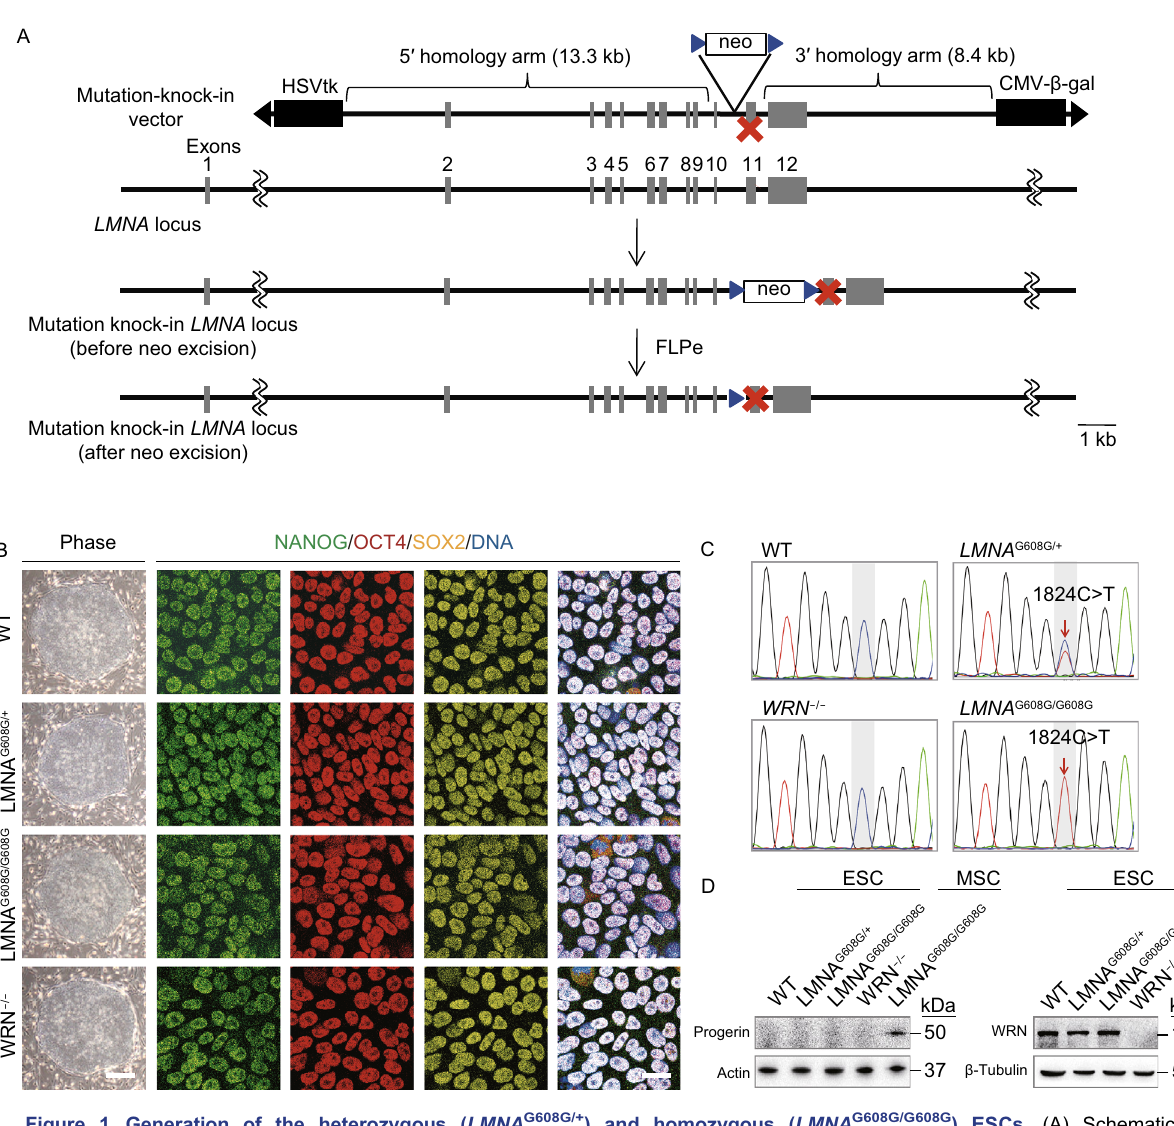
Figure 1. Generation of the heterozygous ( LMNA G608G/+ ) and homozygous ( LMNA G608G/G608G ) ESCs. (A) Schematic representation of LMNA gene editing strategy by HDAdV-mediated homologous recombination. Blue triangles, FRT sites. (B) Morphology and immuno fl uorescence analysis of the pluripotency markers in WT, heterozygous ( LMNA G608G/+ ), homozygous ( LMNA G608G/G608G ) and WRN − / − ESCs. Scale bar, 100 μ m (left); 25 μ m (right). (C) Con fi rmation of the heterozygous and homozygous mutation of LMNA by DNA sequencing. (D) Immunoblotting analysis of progerin and WRN expression in WT, heterozygous ( LMNA G608G/+ ), homozygous ( LMNA G608G/G608G ) and WRN − / − ESCs. Progerin expression in homozygous ( LMNA G608G/G608G ) MSCs was carried out as a positive